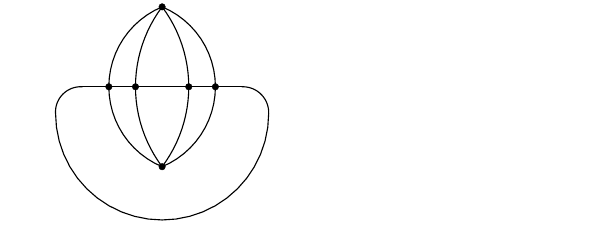
Figure 7 . The unique NNLO vacuum 2PI diagram besides the ladders. All six vertices are